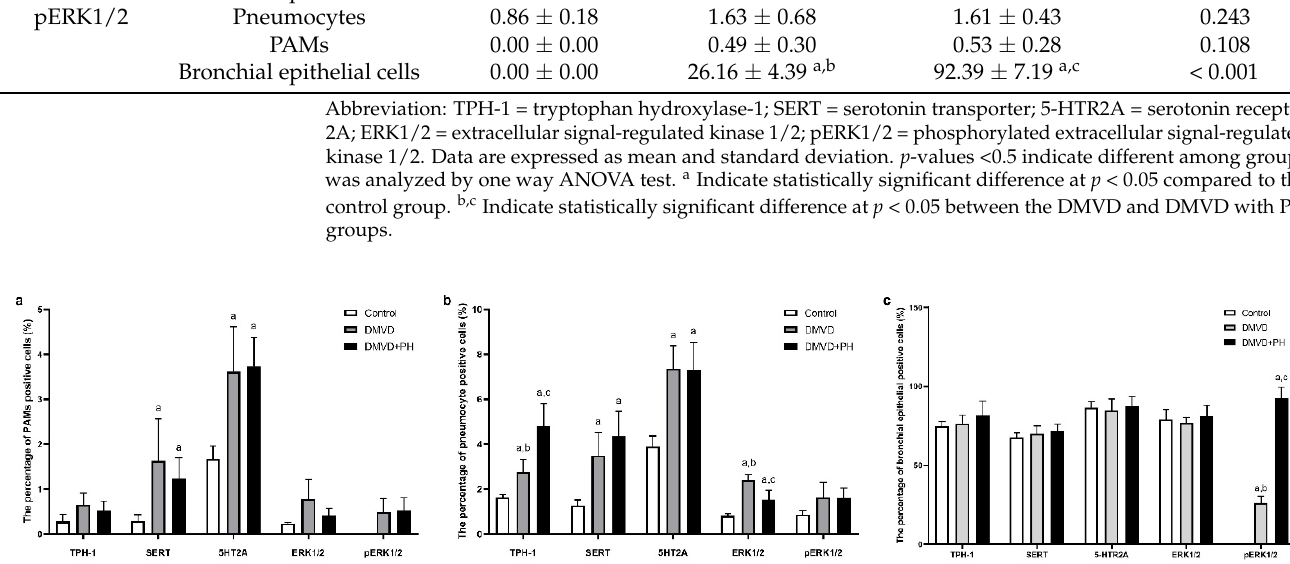
Figure 3. The average percentage of TPH-1, SERT, 5-HTR2A, ERK1/2 and pERK1/2 positive pneumocytes ( a ), PAMs ( b ) and bronchial epithelial cells ( c ) in the control, degenerative mitral valve disease (DMVD) and degenerative mitral valve disease with pulmonary hypertension (DMVD with PH) groups. Data are presented as mean and standard deviation (bars). a Indicate significant difference at p < 0.05 compared to the control group. b,c Indicate significant difference at p < 0.05 between the DMVD and DMVD with PH groups.